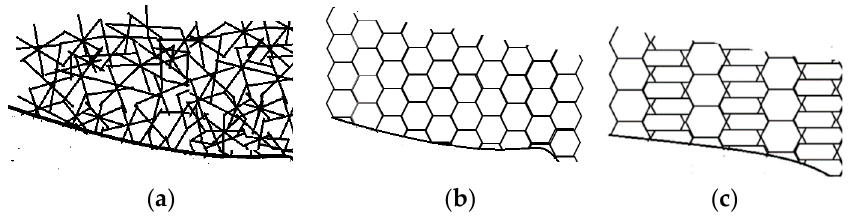
Figure 2. Categorization of lattice structure: ( a ) Disordered lattice structure; ( b ) Periodic lattice structure; ( c ) Pseudo-periodic lattice structure.